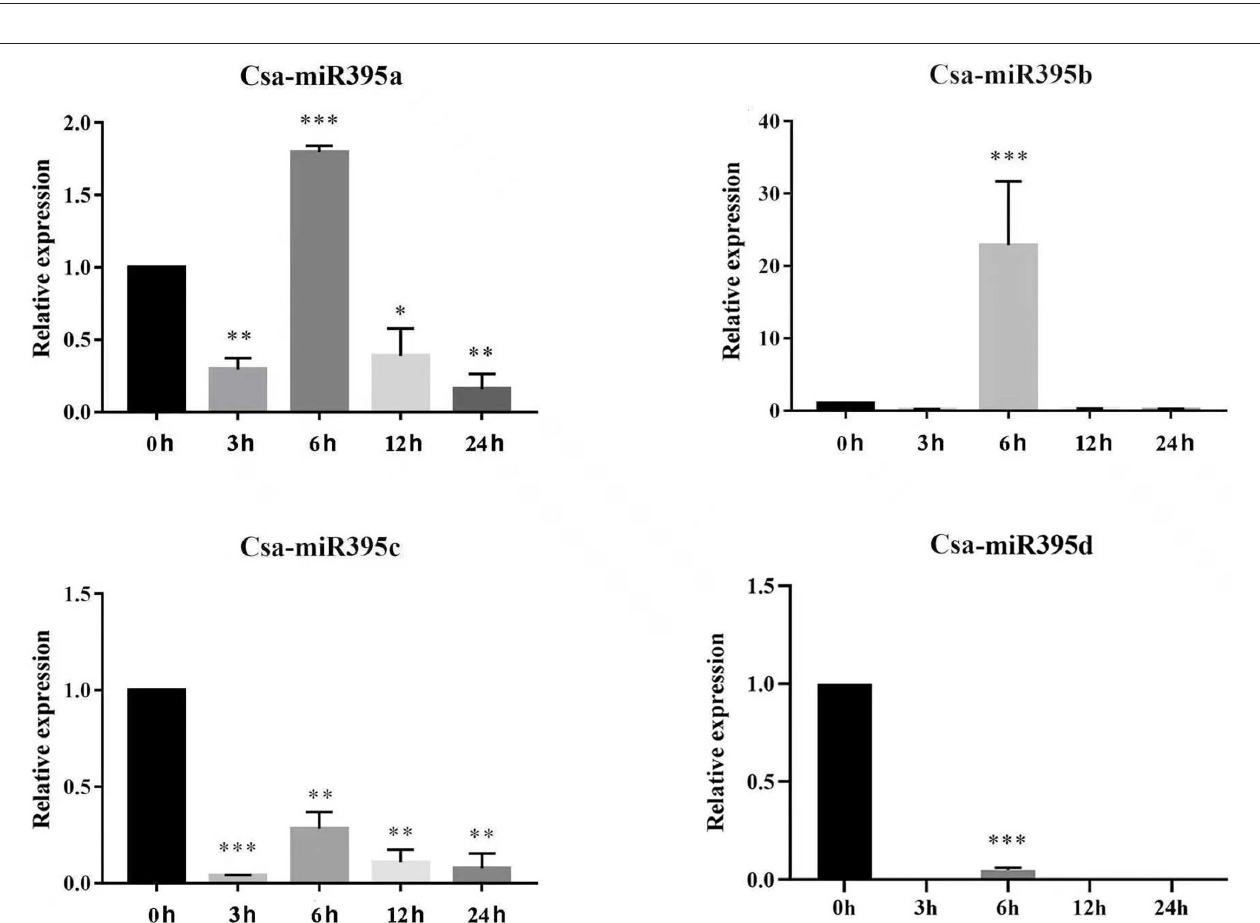
FIGURE 7 | Expression levels of Csa-miR395s in response to PEG stress (0, 3, 6, 12, and 24h). The X-axis represents the hours of 10% PEG6000 treatment. The Y-axis represents the relative expression level of a transcription factor. The values represent the means ± SDs. The significant difference is represented by asterisks according to t -test (* p < 0.05, ** p < 0.01, and *** p < 0.001).